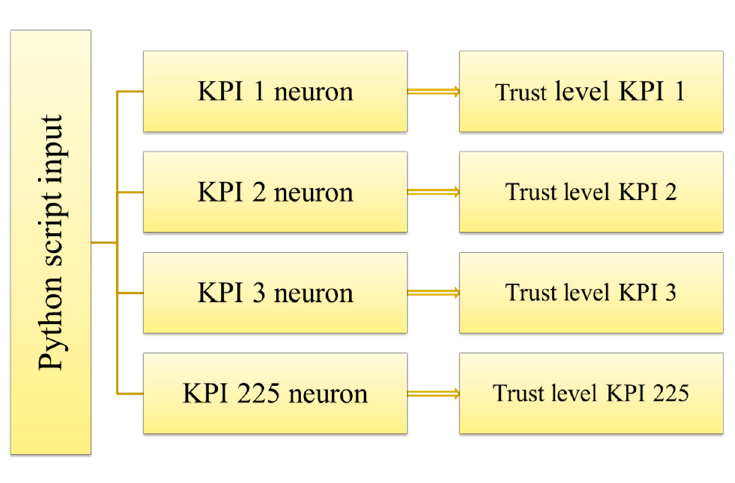
Figure 3. Tree structure of the neural network.